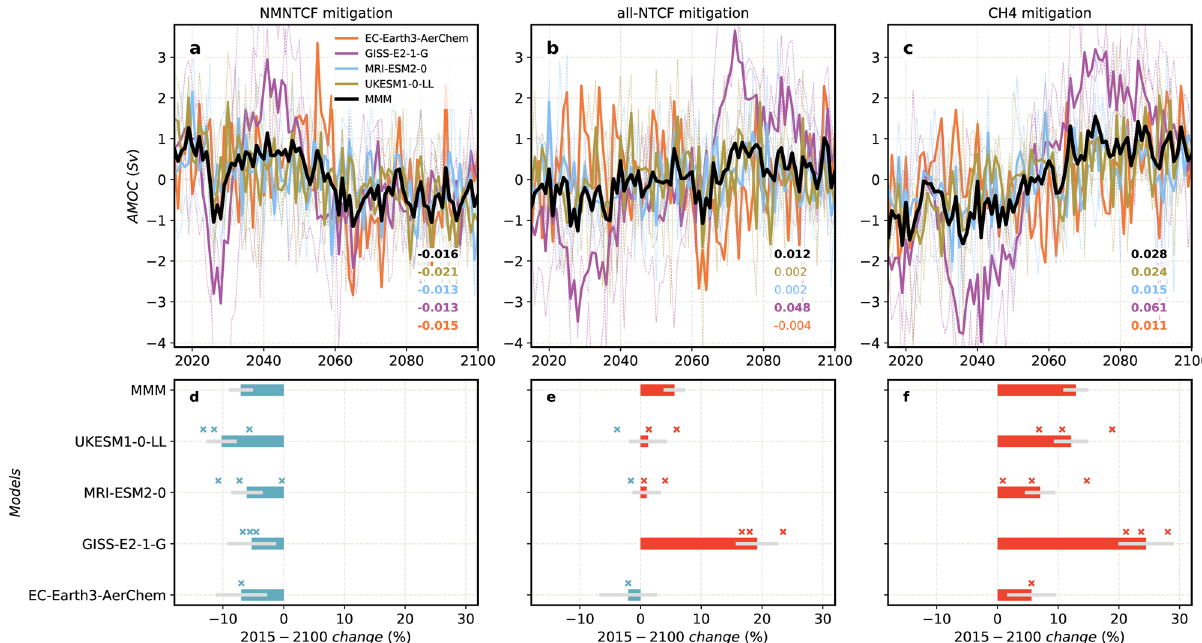
Fig. 2 2015 – 2100 changes in the annual mean Atlantic meridional overturning circulation (AMOC) for the three mitigation signals. a – c Normalized (relative to the long-term 2015 – 2100 climatology) AMOC time series and trends, d – f AMOC percent change (relative to 2015) for each model, including the multi-model mean (MMM) for a , d NMNTCF, b , e all-NTCF, and c , f CH 4 mitigation. In a – c , thin lines show the AMOC time series for each realization; thick lines show the model mean and multi-model mean (black) AMOC time series. Also included in a – c is the slope of the least-squares trend line (units of Sv year − 1 ), color coded by model as de fi ned in the legend. AMOC trends signi fi cant at the 95% con fi dence level are bold. In d – f , AMOC weakening (strengthening) is shown with blue (red) bars. The gray thin lines over the percent change bars represent the 95% con fi dence level. The AMOC percent change for each individual model realization (x ’ s) is also shown in d – f